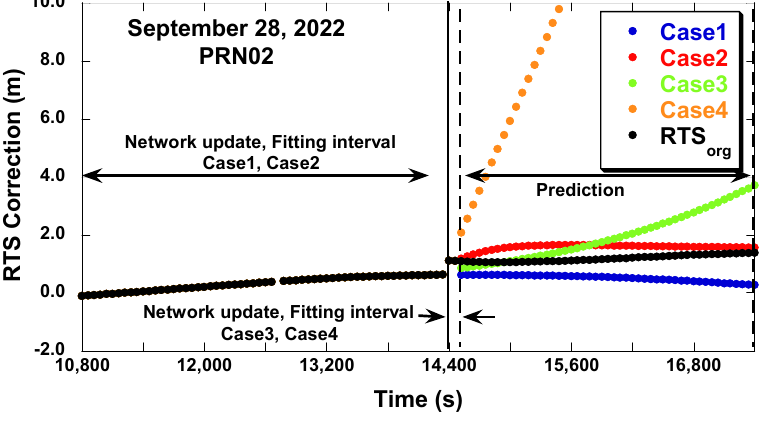
Figure 9. RTS correction prediction results (GPS PRN02 along track, 28 September 2022).